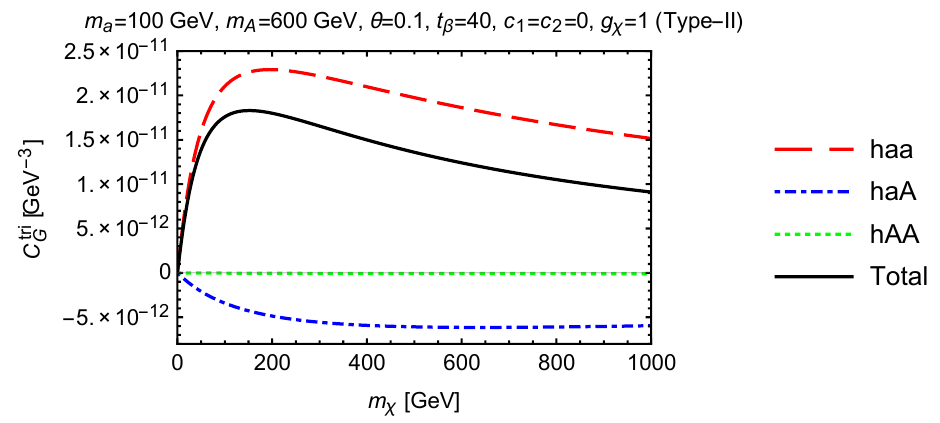
Figure 6 . The contributions from each of the triangle diagrams to C tri m a = 100 GeV, m A = 600 GeV, (cid:18) = 0 : 1, t (cid:12) = 40, c 1 = c 2 = 0, and g (cid:31) = 1. The THDM-type is the type-II. The red dashed, blue dot-dashed, and green dotted lines show the contributions from the haa -diagram, the haA -diagram, and the hAA -diagram, respectively. The black solid line shows the total of these